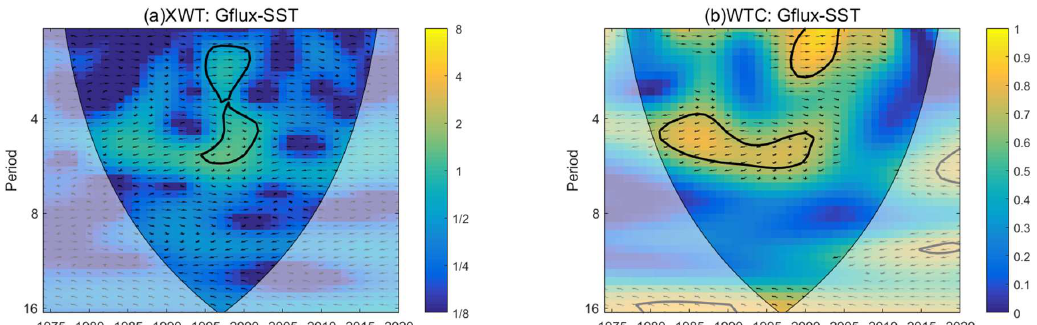
Figure 12. XWT of sea surface heat flux and SST in the tropical western Indian Ocean. ( a ) energy spectrum; ( b ) condensation spectrum.